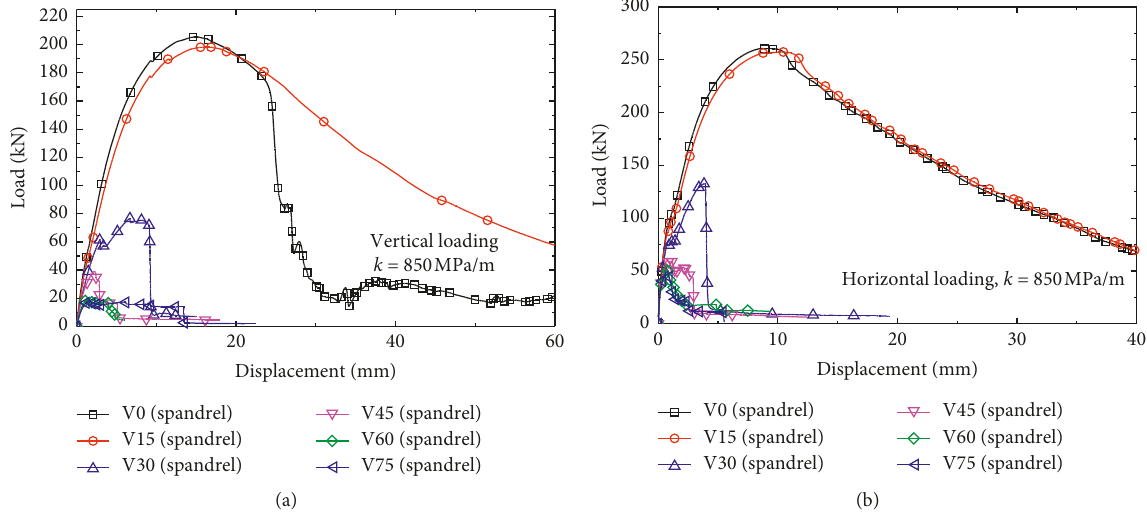
Figure 9: Load-displacement curve of the lining under spandrel voids. (a) Vertical loading. (b) Horizontal